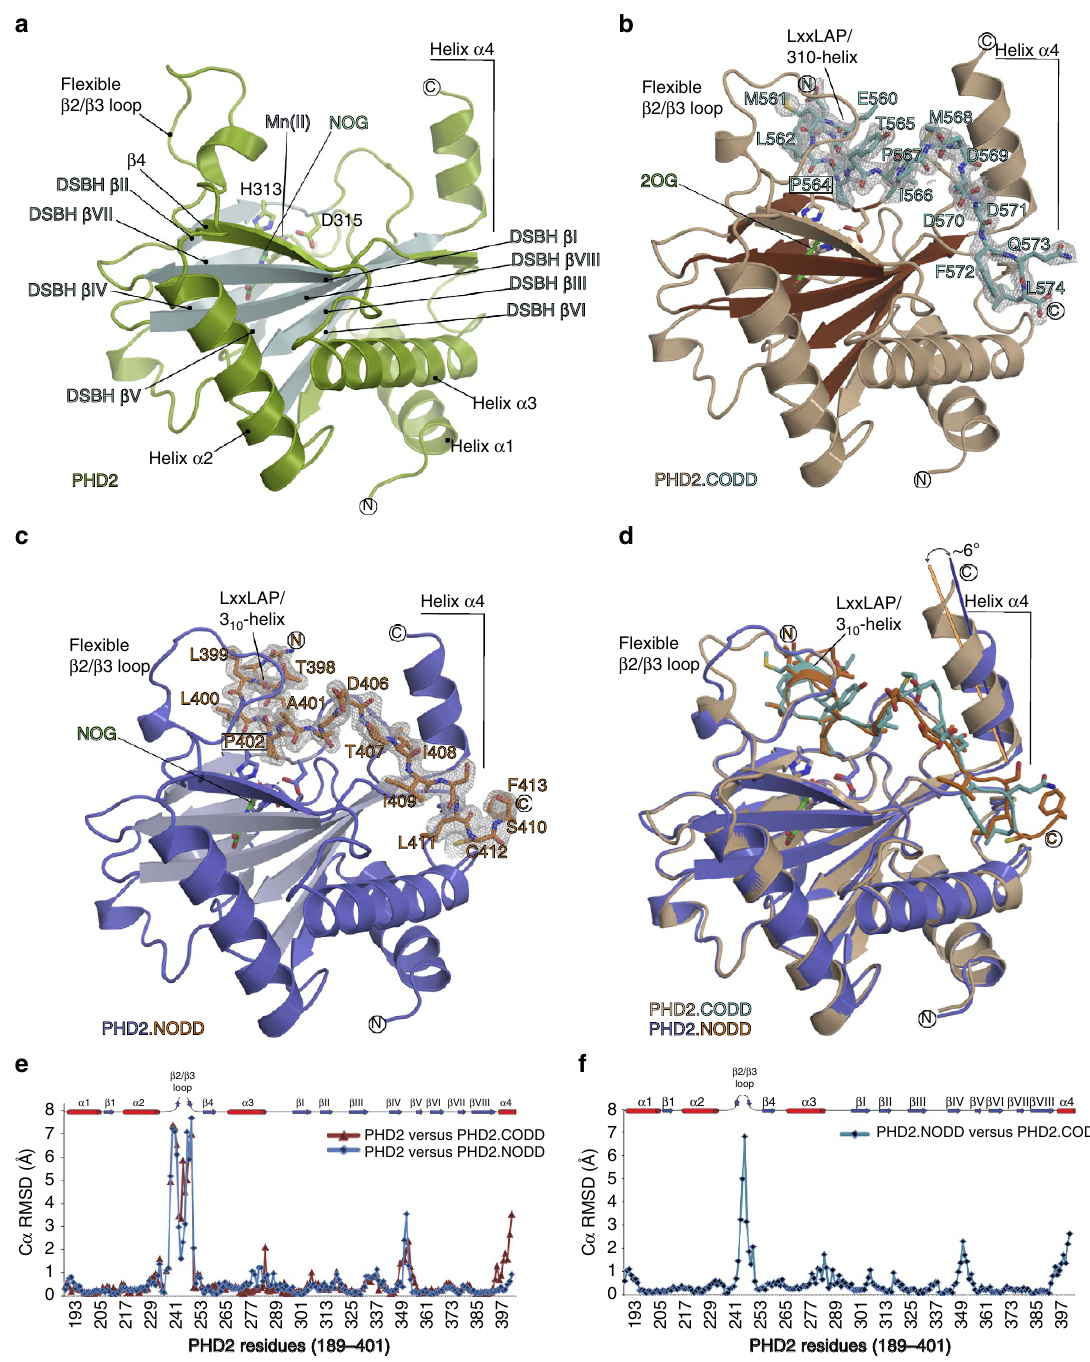
Figure 4 | Overall binding modes of NODD and CODD to PHD2. Views from PHD2.NOG ( a , PDB: 5L9R), PHD2.2OG.CODD ( b , PDB: 5L9B) and PHD2.NOG.NODD complexes ( c , PDB: 5L9V) showing secondary structural elements involved in NODD/CODD selectivity. ( d ) Superimposition of PHD2.CODD and PHD2.NODD structures reveals apparently more ‘induced fit’ in CODD (compared with NODD) binding involving the b 2/ b 3 loop and a 4. ( e ) C a r.m.s.d. plots of PHD2 structures with/without CODD (brown) and NODD (blue) reveal similar PHD2 backbone conformations for the major and minor b -sheets of the DSBH and surrounding three a -helices (1–3), but clear differences especially in the b 2/ b 3 loop (aa 237–250), b IV/ b V loop (aa 348–353) and C-terminal helix a 4 (393–401, CODD). ( f ) C a r.m.s.d. plot comparing the PHD2.NODD and PHD2.CODD structures shows differences mainly in the b 2/ b 3 loop (aa 243–250) and C-terminal regions (aa 393–401).